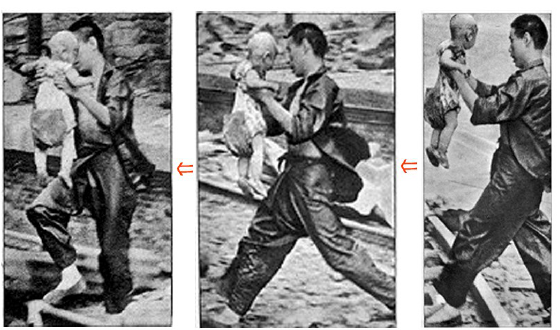
Figure 4. Filmed images of baby Ping-Mei. Source: LOOK Magazine.